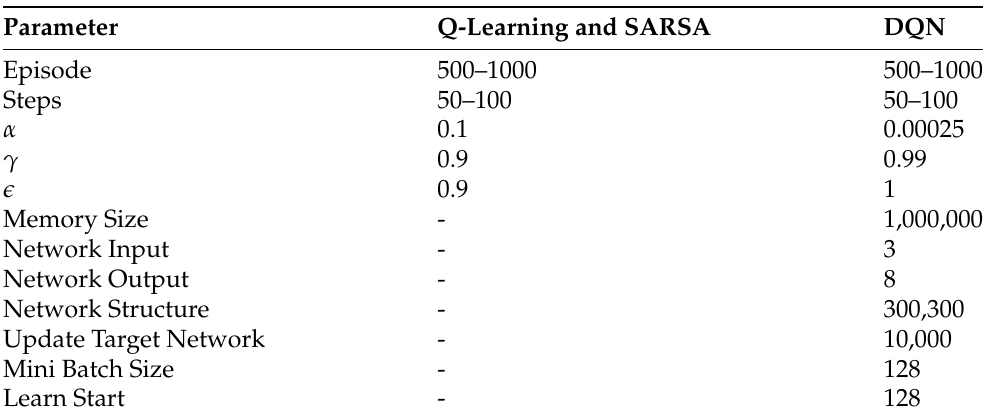
Table 5. Simulation hyperparameters.